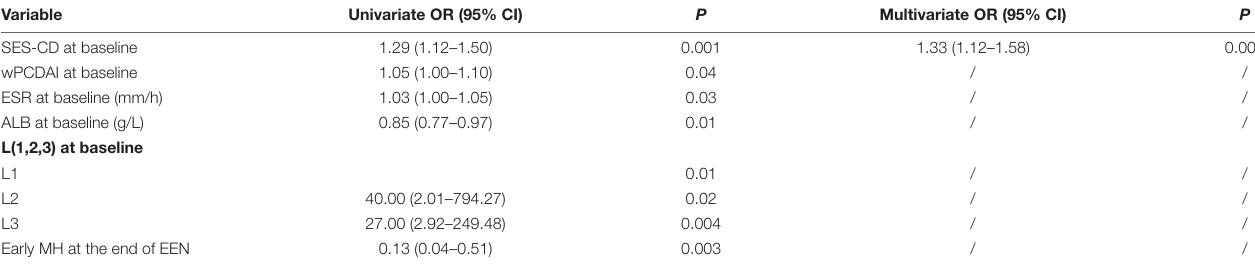
dependent variable in multivariate analysis: MH at 1 year post.EEN. n = 50 patients. MH, mucosal healing; EEN, exclusive enteral nutrition; OR, odds ratio; 95% CI, 95% confidence interval; SES-CD, Simple Endoscopic Score for Crohn’s Disease; wPCDAI, weighted Pediatric Crohn’s Disease Activity Index; ESR, erythrocyte sedimentation rate; ALB, albumin.